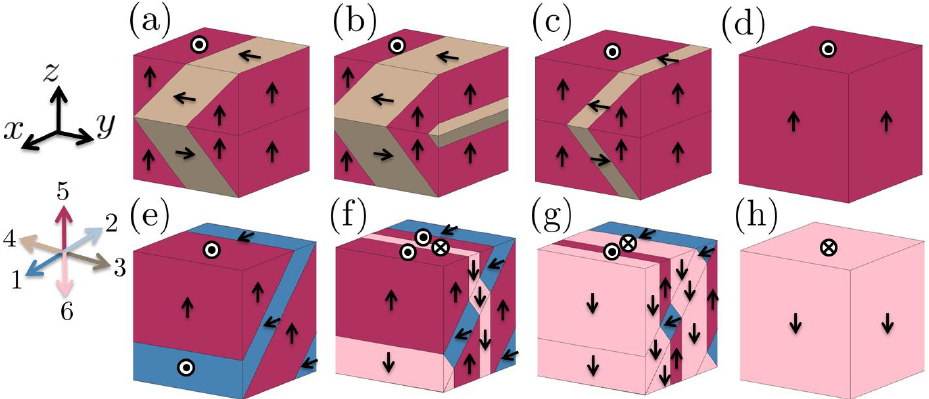
Figure 5. A schematic domain evolution when a BaTiO electric field and a small compressive stress along z direction, where the polarization directions of crystal variants numbered from 1 to 6